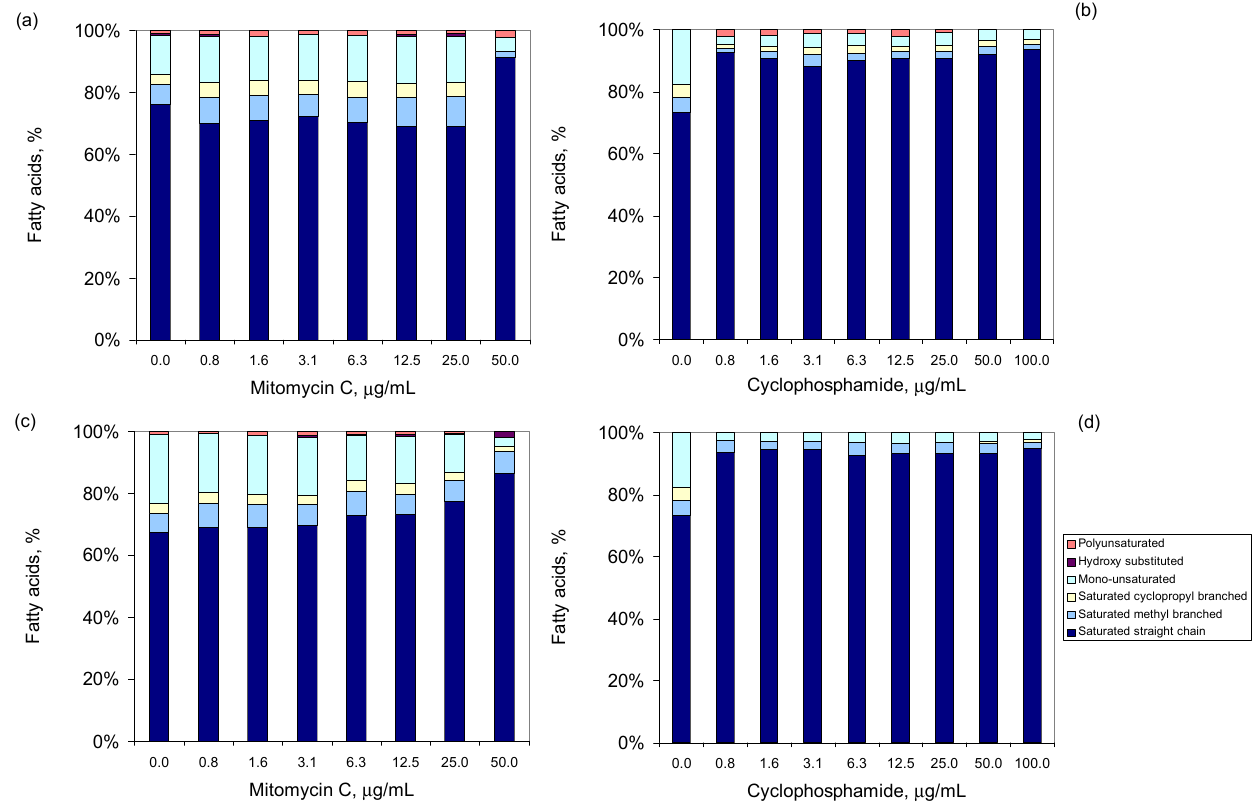
Figure 2. Fatty acid composition of the phospholipids of the cellular membrane of S. aureus cells exposed to mitomycin C ( a , c ) and cyclophosphamide ( b , d ), for 2 ( a , b ) and 24 h ( c , d ). Data presented are mean of three independent assays.